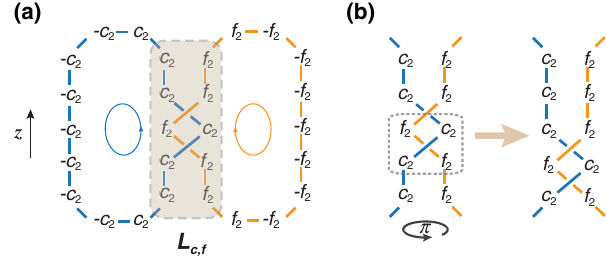
FIG. 13. (a) The configuration of the link L quasiparticles associated with it in each layer. The layers are horizontal and are not drawn in this figure. In this link L string and the f string have the linking number 1. Their orientation is indicated by the colored arrow (blue for the c string and orange for the f string). (b) The operation that brings the linked part of the two strings down by one layer along the − z direction is a π rotation of the part of the link indicated by the dashed gray